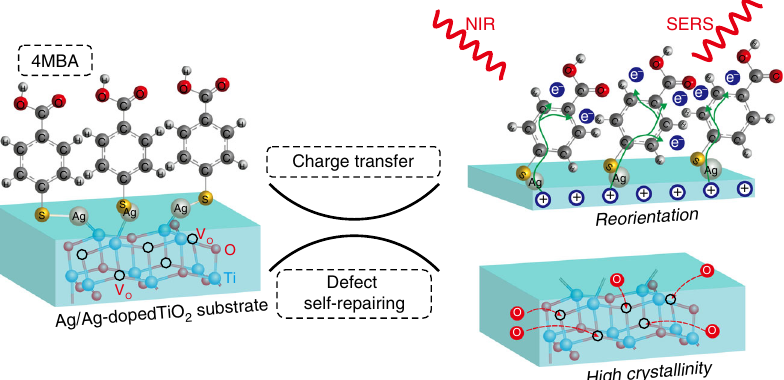
Fig. 1 NIR light-induced irreversible accumulated SERS behavior of the 4MBA/Ag/Ag-doped TiO 2 hybrid system. Three mechanisms are proposed to explain this phenomenon: (1) NIR light induces a thermal effect on the substrate, which results in higher crystallinity to change polarizability; (2) NIR light induces CT between the substrate and 4MBA with the assistance of V O defects; (3) the electrostatic attraction causes the reorientation of 4MBA molecule on the surface of the Ag/Ag-doped TiO 2 substrate. Here, the green arrows represent the transfer path of electrons between the Ag/Ag-doped TiO 2 substrate and 4MBA molecules, and the red arrows display fi lling of V O defect by oxygen